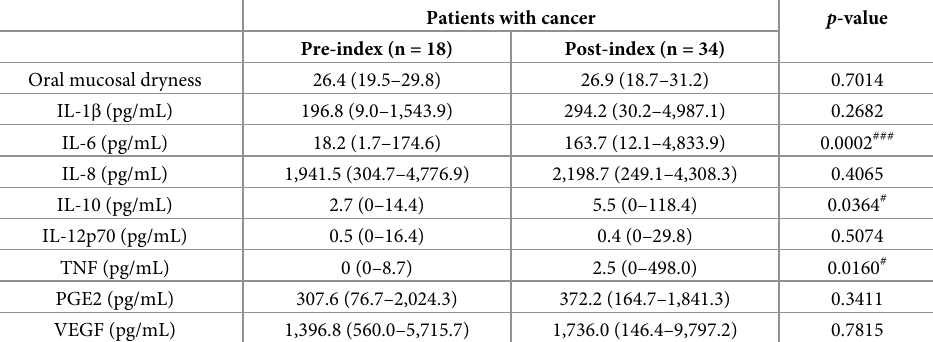
Table 3. Differences in measurements between pre- and post-index patients with